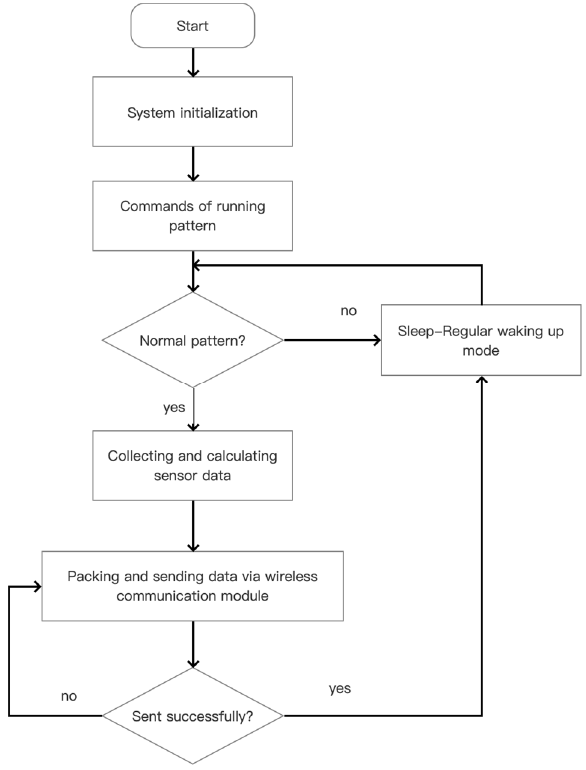
Figure 5. Flow chart of nodes of IoT system in citrus orchard.